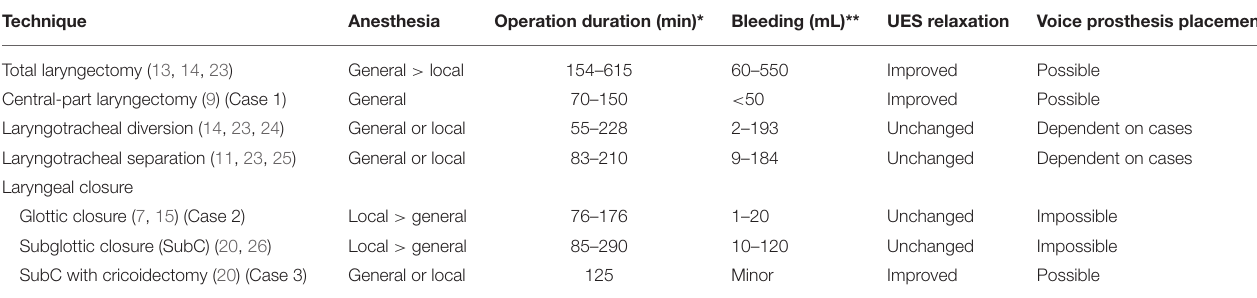
TABLE 1 | Characteristics of aspiration prevention